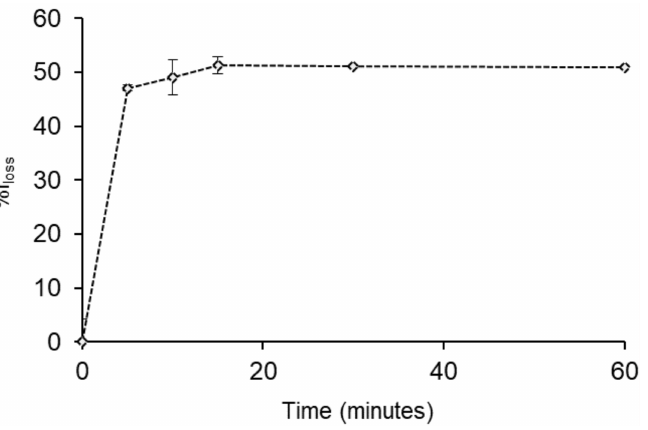
Figure 4. The detection time of E. coli (10 7 CFU/mL) by 1 mg/mL of SNP-RB in solution plotted against the % I loss . The SNP-RB samples were excited at 553 nm and the % I loss were calculated from the maximum intensity at 580